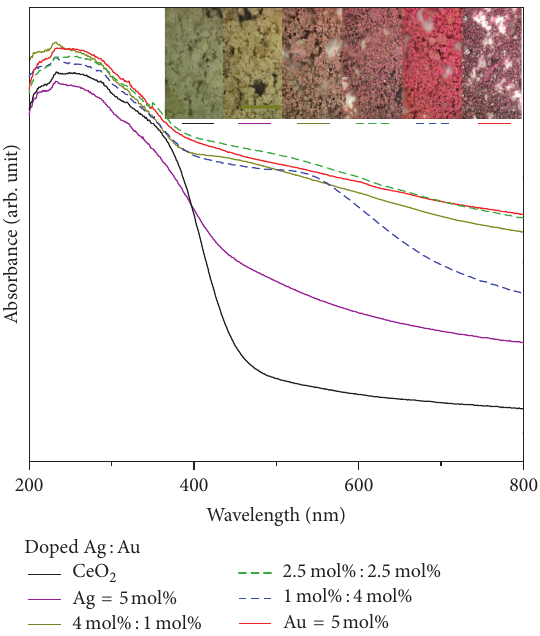
Figure 3: UV-visible diffuse reflectance spectra (expressed in terms of Kubelka–Munk absorbance arbitrary unit) of undoped CeO 2 and Au and Ag doped and codoped (5/0, 0/5, 4/1, 2.5/2.5, and 1/4mol.%) CeO 2 catalysts. Optical microscopy images (inset) show the colors of the corresponding samples.